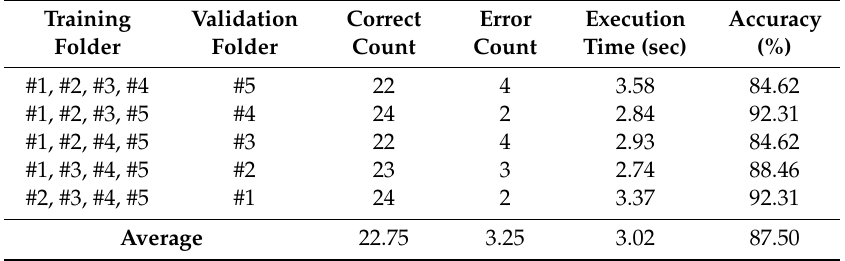
Table 3. k -fold cross-validation for the approach of ANN with the DFT interpolation